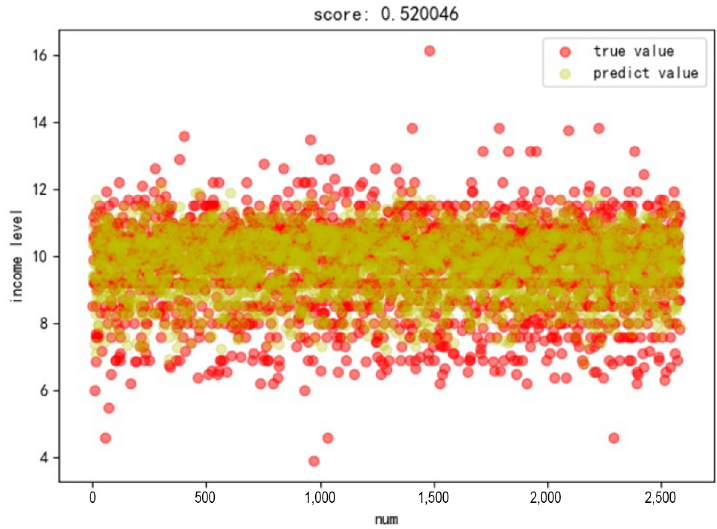
Figure 4. The visualization of annual income prediction result